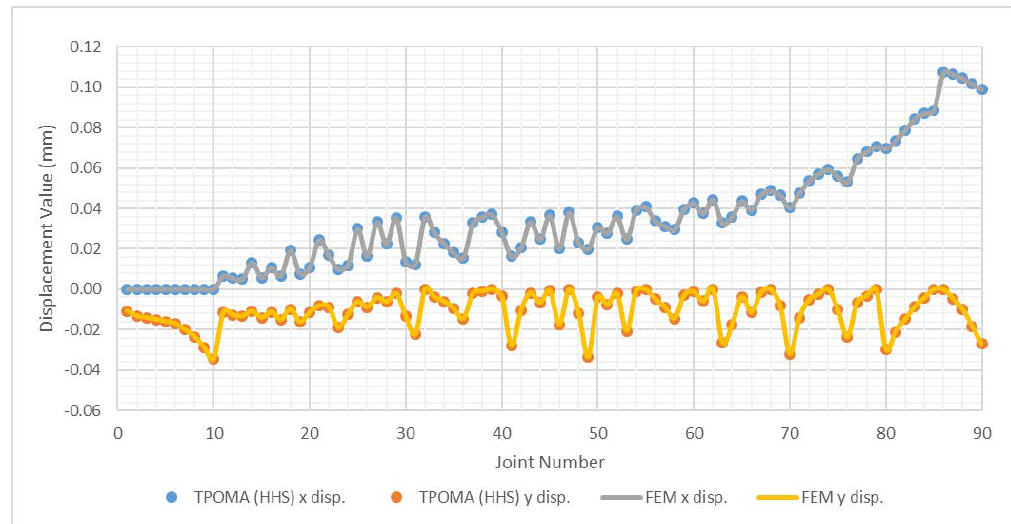
Figure 8. Nodal displacements for Structure 3.